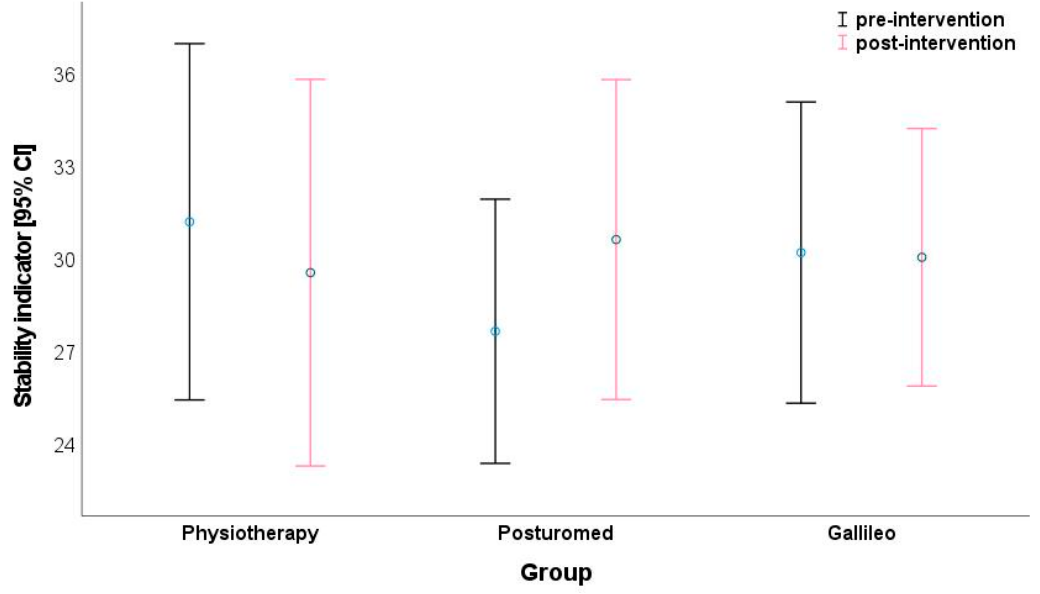
Figure 2. Comparison of stability indicator depending on group and time (time effect: p = 0.666; η p2 = 0.003).